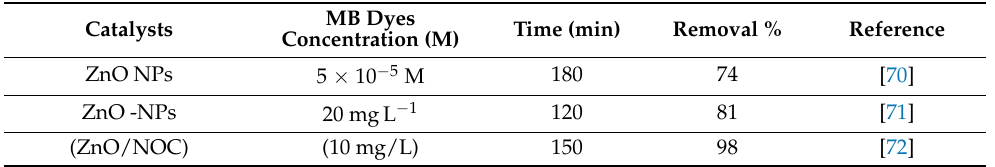
Figure 16. Dye removal efficiency of 8. 22 × 10 −5 M MB solution in the presence of various scavengers. Table 3. Comparison of photocatalytic activity of synthesized ZnO NPs for MB with previously reported works.